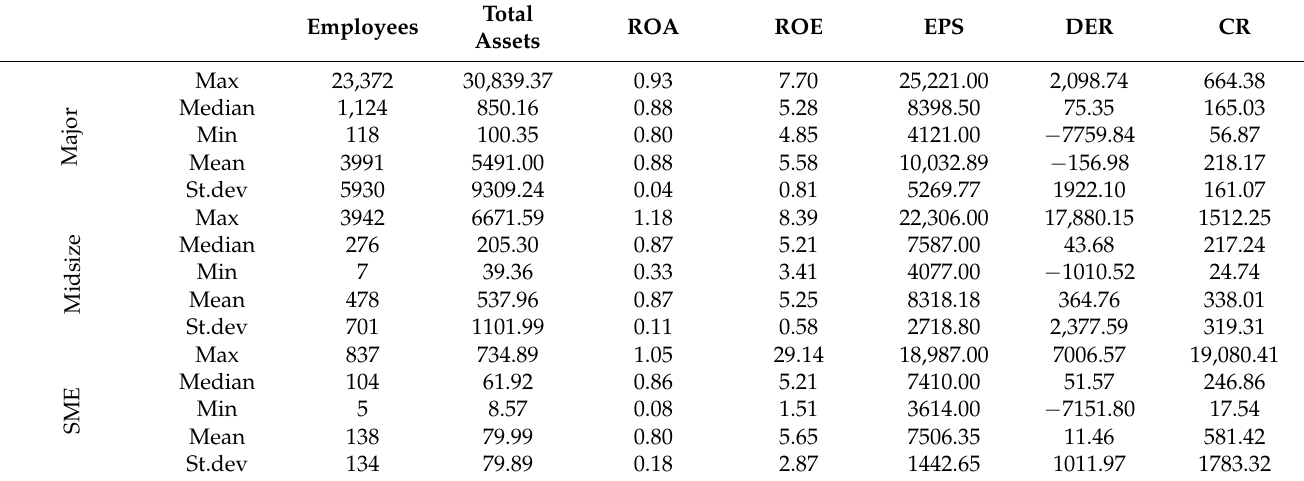
Table 3. Descriptive statistics: ICT service firms.